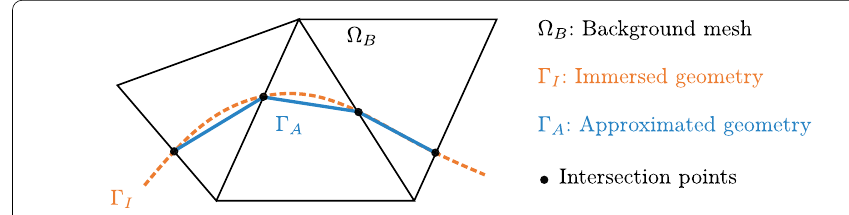
Fig. 7 Approximation of an immersed geometry within each intersected element of a background mesh